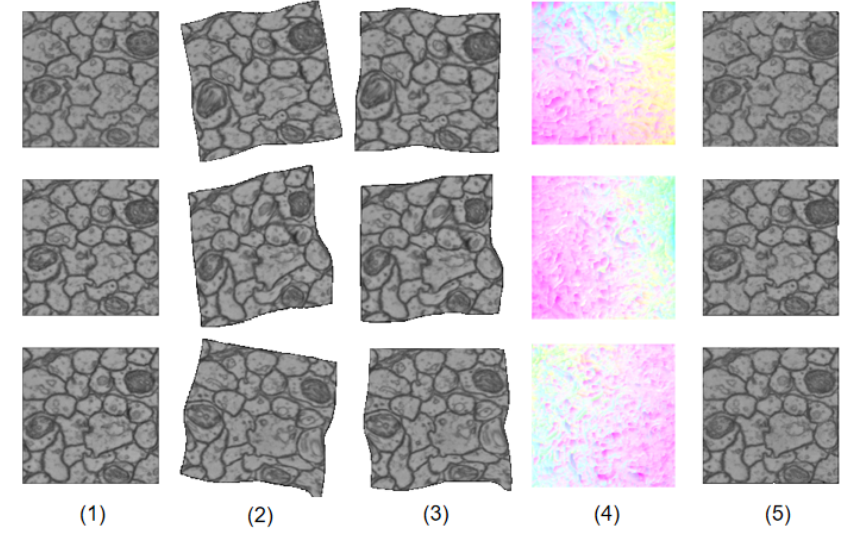
Figure 3. An illustration of how DualNet works. ( 1 ) reference images. ( 2 ) source images. ( 3 ) linearly transformed images. ( 4 ) nonlinear deformation filed. ( 5 ) final